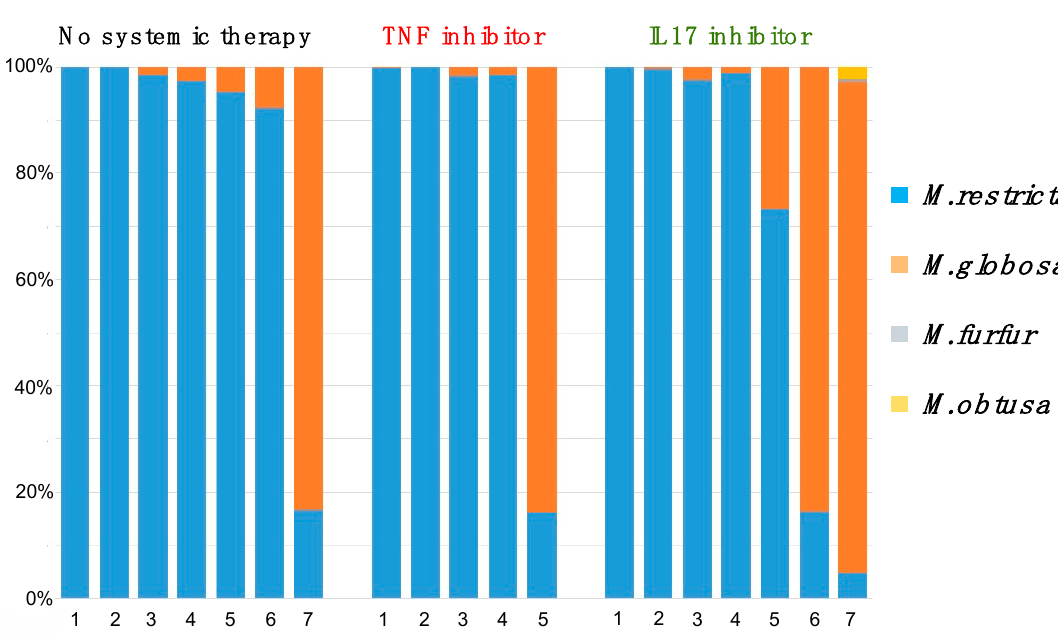
Figure 3. Bar chart showing the relative distribution species within the genus Malassezia and description of the color bars. M. restricta was dominant in 6 / 7 samples from the no-therapy group (86%), 4 / 5 samples from the TNFi group (80%), and 5 / 7 samples from the IL-17i group (71%). Malassezia species other than M. restricta showed predominance of M. globosa. Table 3. Association between M. restricta and M. globosa and patient gender.